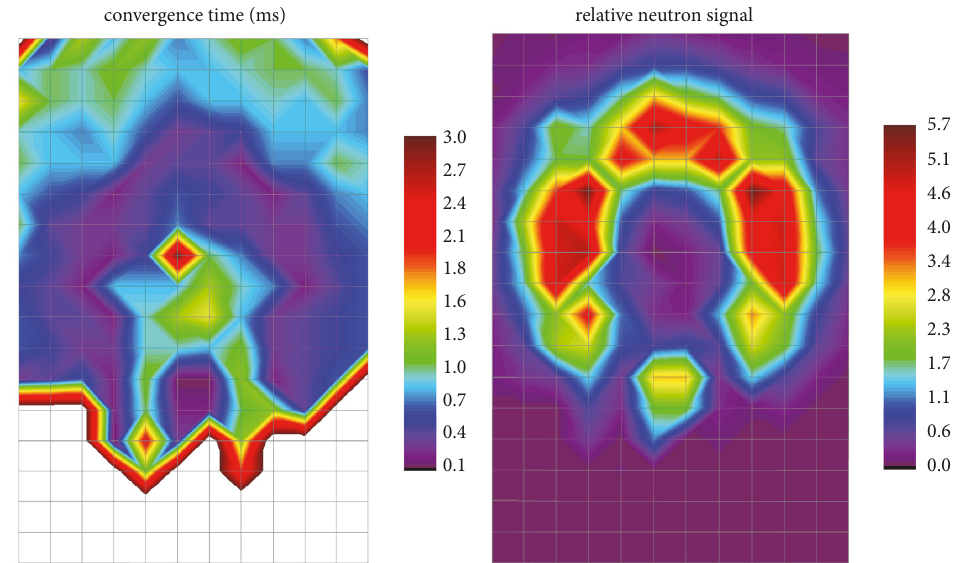
Figure 5: Convergence time and amplitude of neutron signal